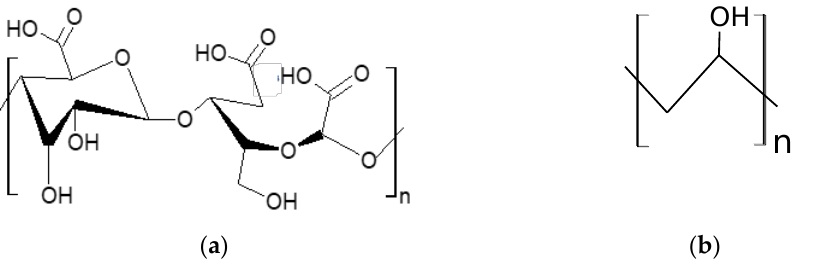
Figure 2. Chemical structure of the compound used to obtain OxC25 hydrogel: ( a ) 2,3,6 tricarboxy- cellulose; ( b ) poly(vinyl alcohol).